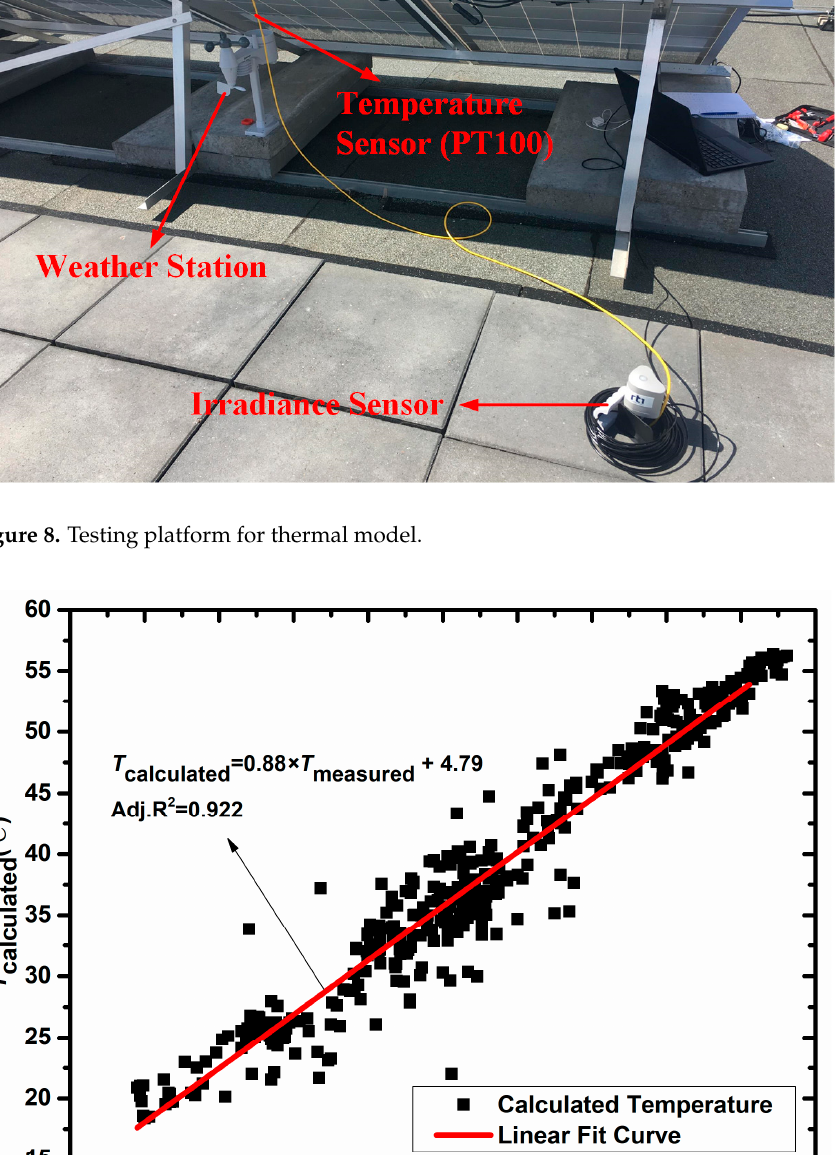
Figure 9. Calculated module temperature as a linear function of the measured module temperature.